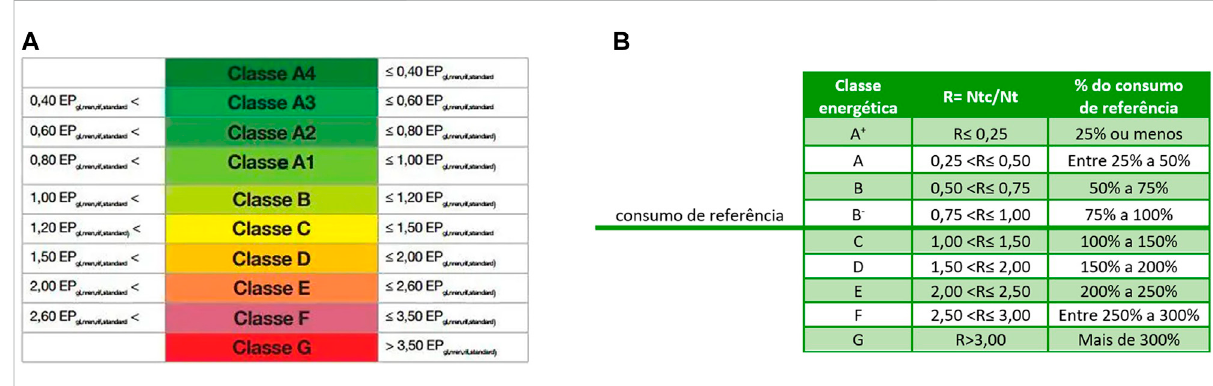
FIGURE 1 Classi fi cation scale of residential buildings according to the global Energy Performance (EP) index: (A) Italian ranking (interm, 2015); (B) energy classes in Portugal (adapted from ADENE, 2022).